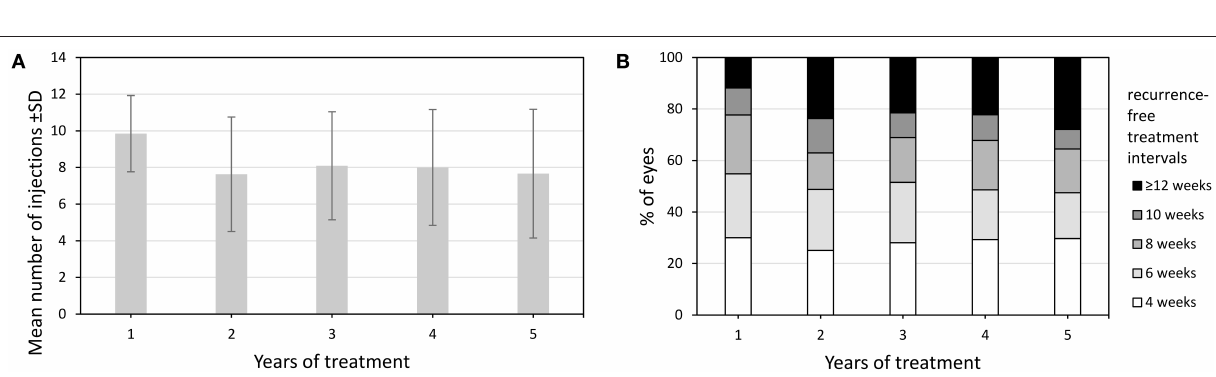
FIGURE 4 | (A) Number of injections of eyes treated in TER from baseline to year 5. (B) Change in distribution of recurrence-free treatment intervals of eyes treated in TER from year 1 to year 5.Values are shown as mean ± SD, standard deviation and